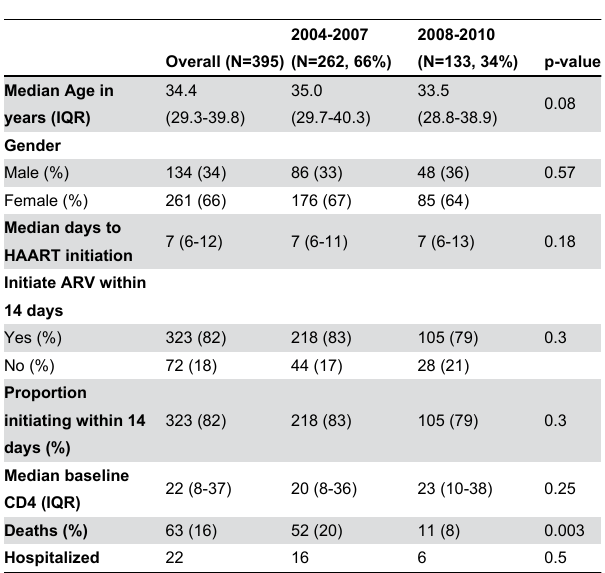
Table 3. Comparison of variables between eras.